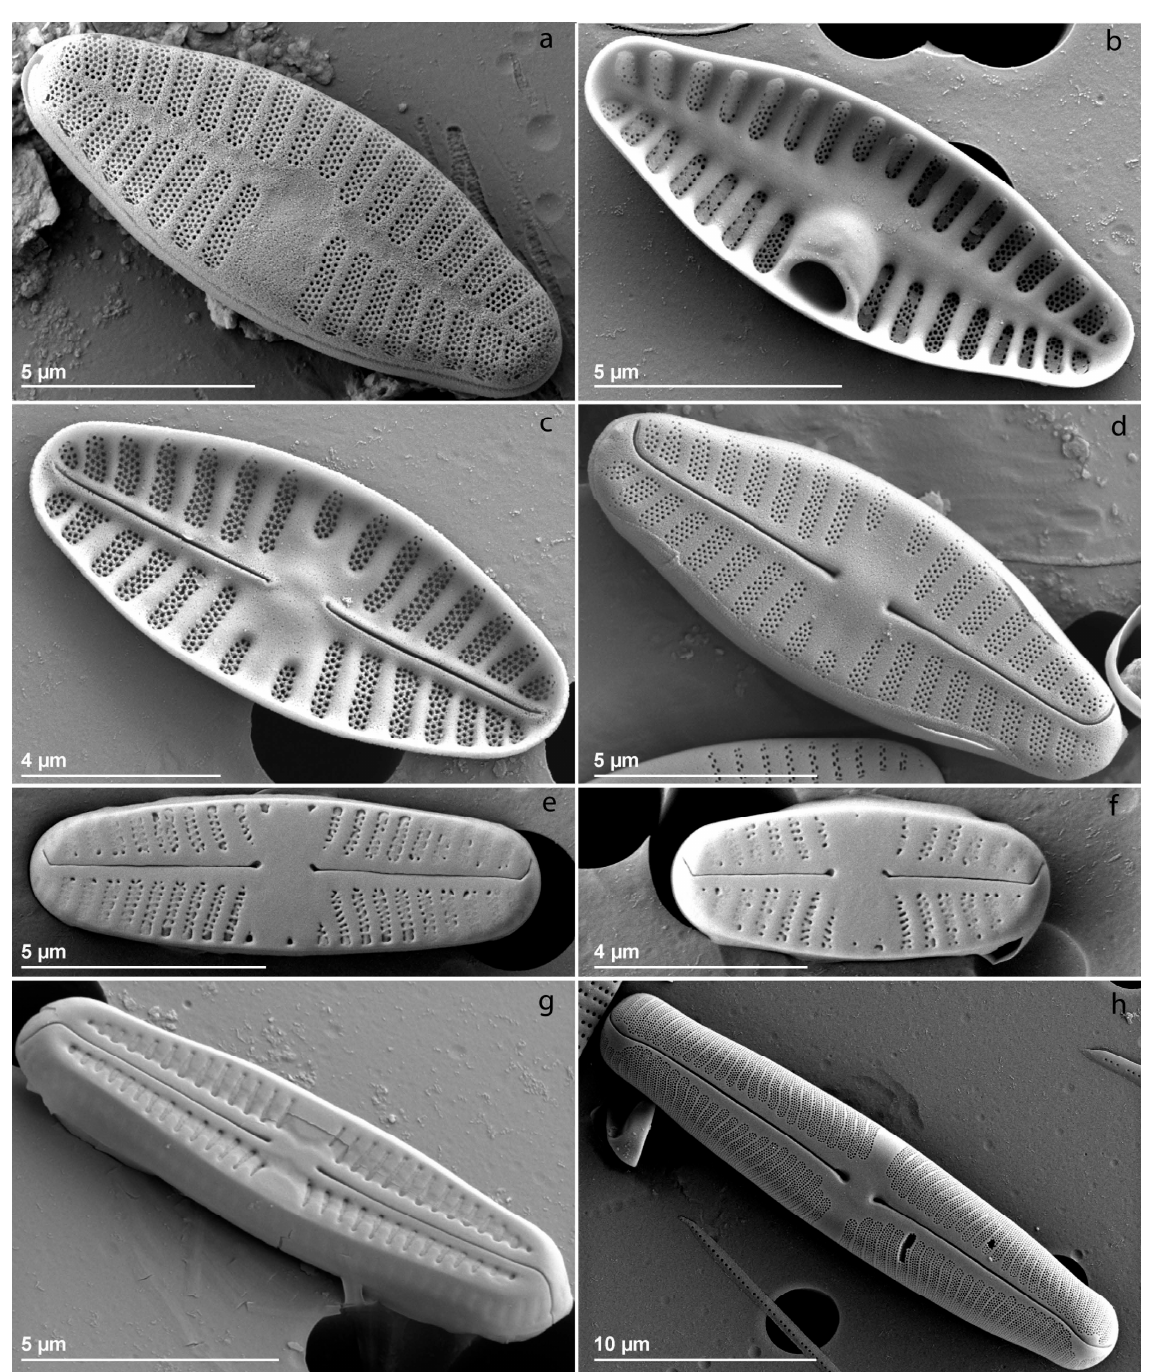
Figure 7. Scanning Electron Microscopy illustrations of some individuals observed in the studied springs. Planothidium frequentissimum ( a – d ). Sellaphora labernardierei ( e , f ). Chamaepinnularia salina ( g ). Pinnularia kuetzingii ( h ).